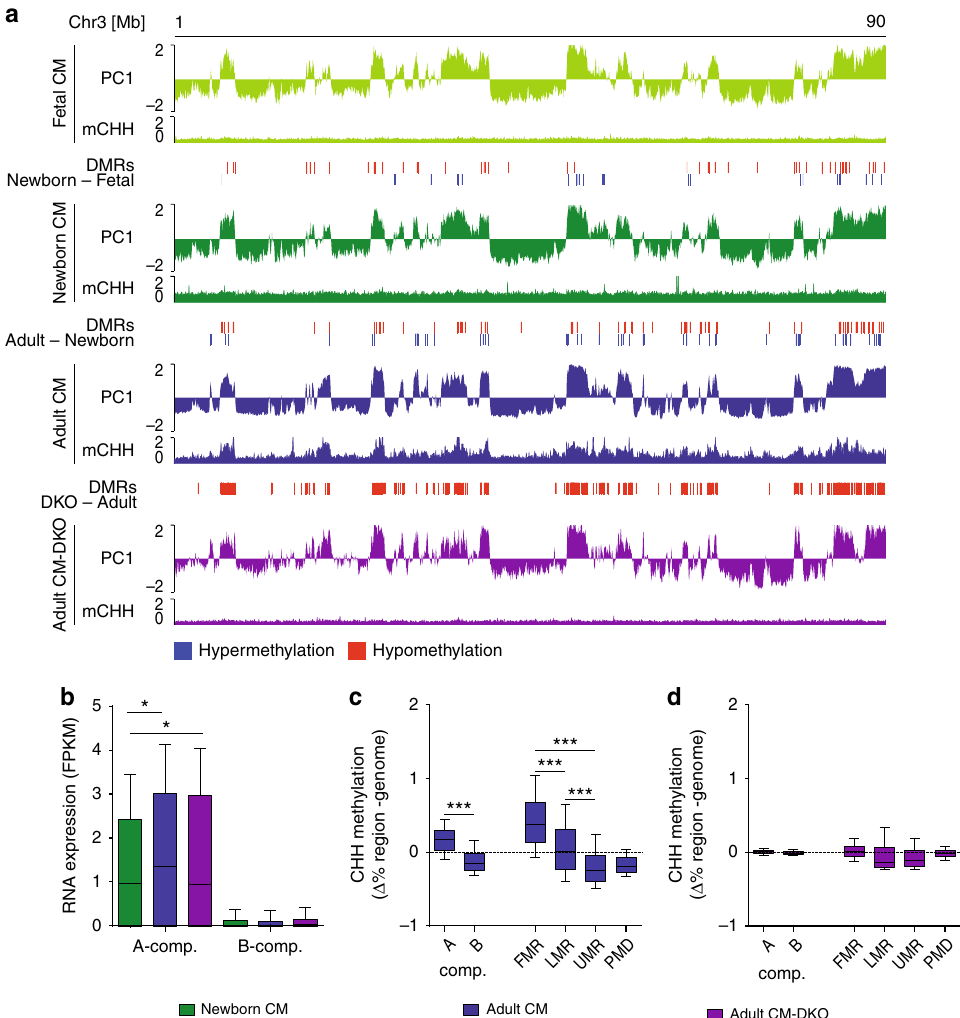
Fig. 3 DNMT3A/B establishes non-CpG methylation in A compartments of post mitotic CM. a Originial traces of PC1 values corresponding to A/B compartments (A, PC1 > 0; B PC1 < 0), regions with differential CpG methylation ( Δ > 40%) and CHH methylation (%). Differential CpG methylation during CM maturation and upon fetal ablation of DNMT3 were found in A compartments. CHH methylation is present in A compartments of adult cardiac myocytes in a DNMT3-dependant manner. b Gene expression occurs mainly in A compartments of postnatal CM. Ablation of DNMT3A/B had no signi fi cant effect on gene expression in CM. c , d Statistical analysis of CHH-methylation relative to the genome shows signi fi cant enrichment in A compartments and in fully methylated regions (mCpG > 85%). No differential CHH methylation is detectable in CM-DKO. Data shown are from n = 2 – 3 Hi-C, n = 3 RNA-seq, n = 2 – 3 WGBS experiments. Shown are boxplots with 10 – 90 percentile whiskers of FPKM values. * P < 0.05, *** P < 0.001